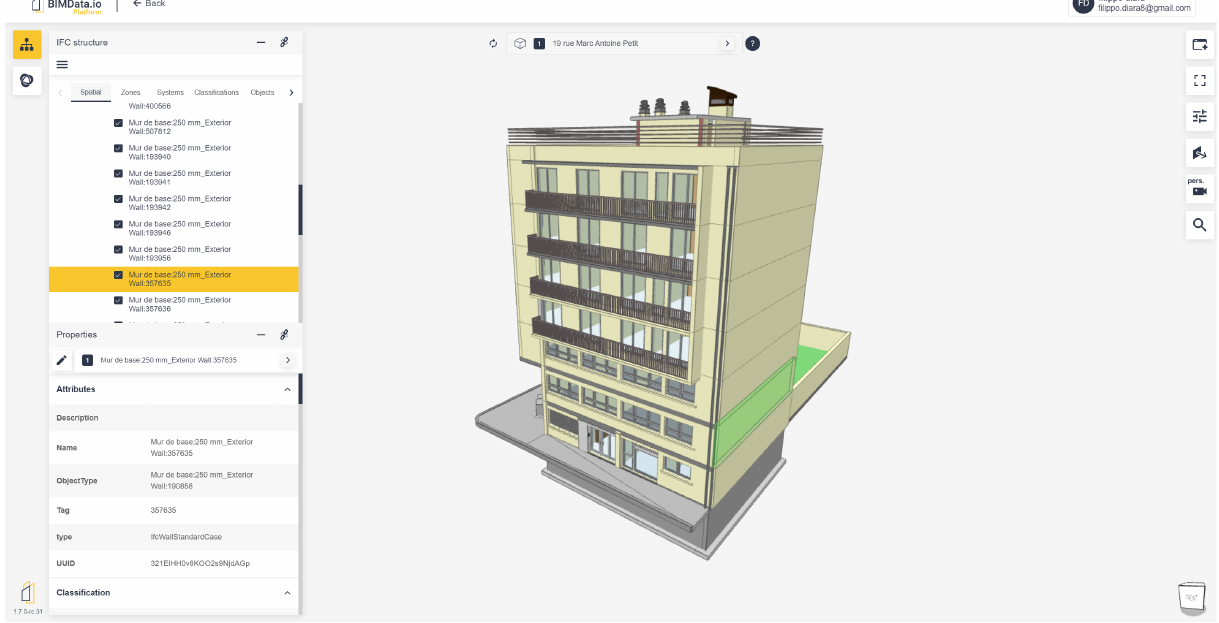
Figure 2. BIMData default platform and viewer. Detail of the sample model with object tree and related properties. Default plugins and functionalities are on either side.